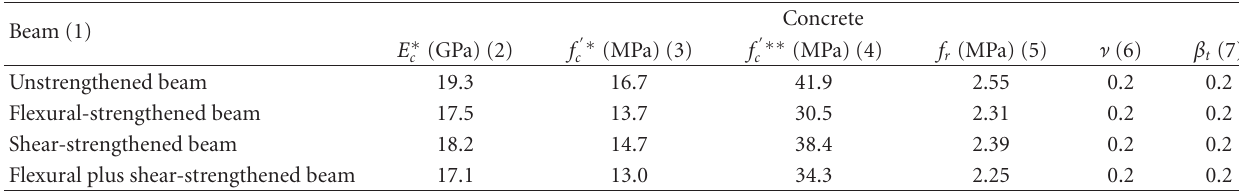
Table 1: Summary of material properties for